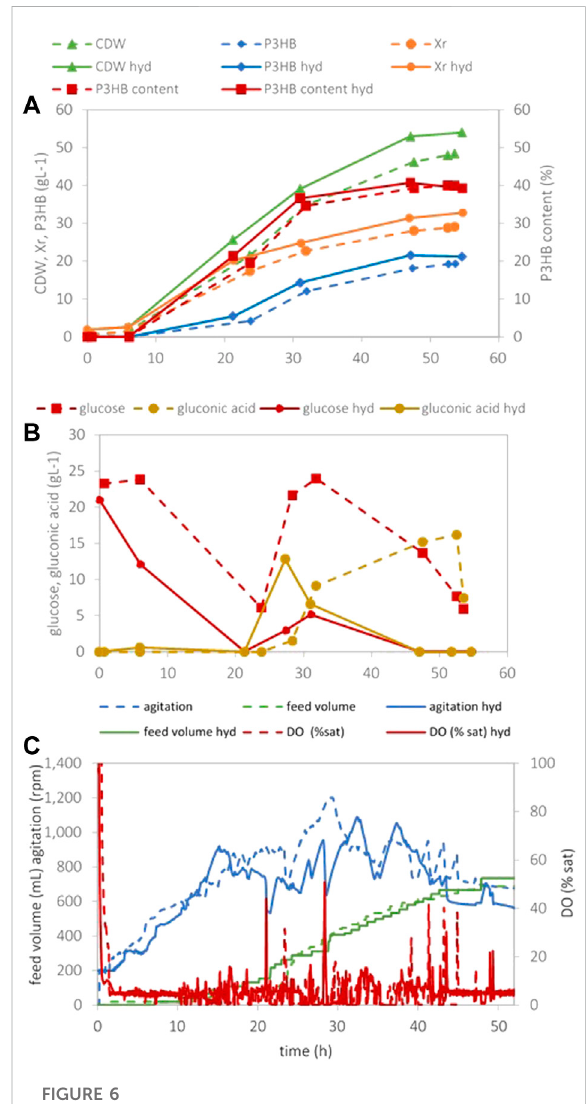
FIGURE 6 Data obtained in H. boliviensis fed-batch cultivation using glucose or hydrolysates of Gelidium residues in the batch and the feed – mineral medium supplemented with 25 g/L of glucose (dashed line) or hydrolysate (solid line), 1.5 g/L K 2 HPO 4 , and7.0 g/LNH 4 Cl atpH 7.5 and 5%satof DO. A 500 ml solution containing 305 g/L of glucose and 45 g/L NaCl or the hydrolysate supplemented with 45 g/L NaCl was used as feed. (A) Cell dry weight, P3HB, residual cell concentration, and P3HB cell content during the cultivation, (B) glucose and gluconic acid concentrations, and (C) data acquired automatically during the